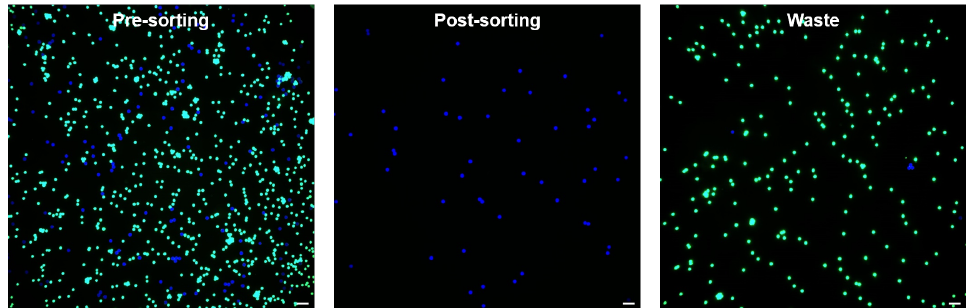
Figure 6. Fluorescence microscopy images of bead sorting performed on the upgraded system (scale bars 100 µ m). The blue and green dots indicate the target 15 µ m bead and the non-target 10 µ m bead,